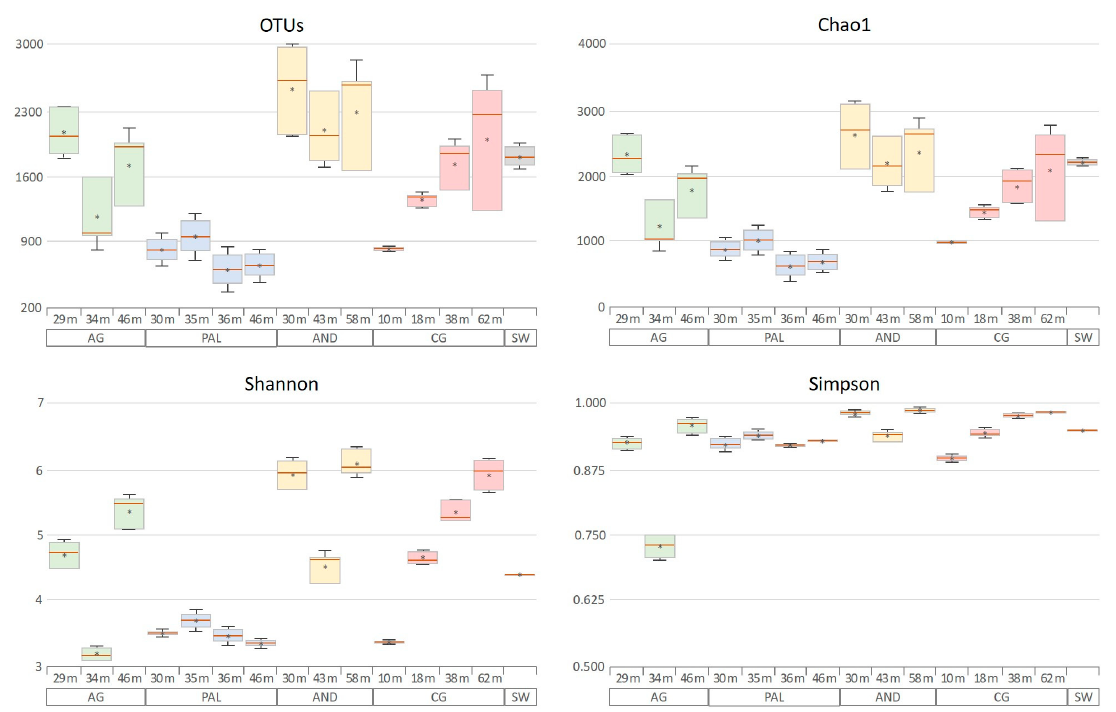
Figure 5. Alpha diversity values found for the different aquifers and depths studied. The red line indicates the median value and the asterisk indicates the mean. The lower limit of the box marks the position of the first quartile and the upper limit the position of the third quartile. The upper and lower whiskers represent the maximum and minimum values, respectively.